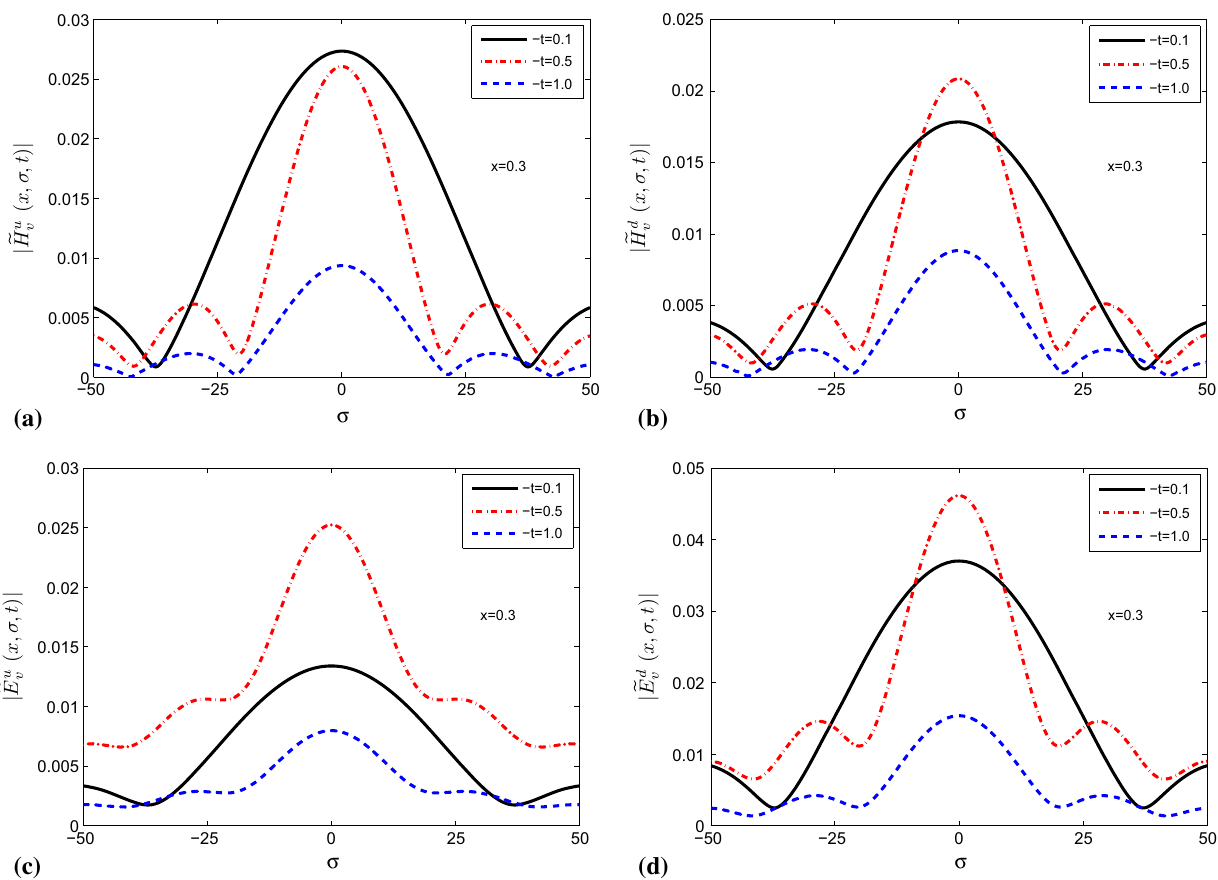
Fig. 8 (Color online) Plots of the helicity-dependent GPDs in longitudinal impact space vs. σ and different values of − t in GeV 2 , for a fixed value of x = 0 . 3. The left panel is for u quark and the right panel is for the d